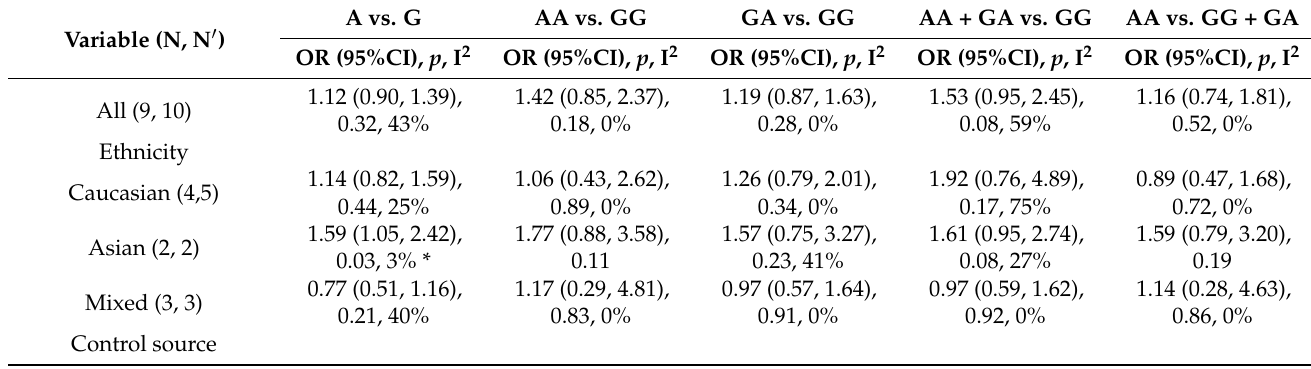
Table 7. Subgroup analyses based on ethnicity, control source, disease form, and sample size for five genetic models of TNF- α ( − 308 G > A)